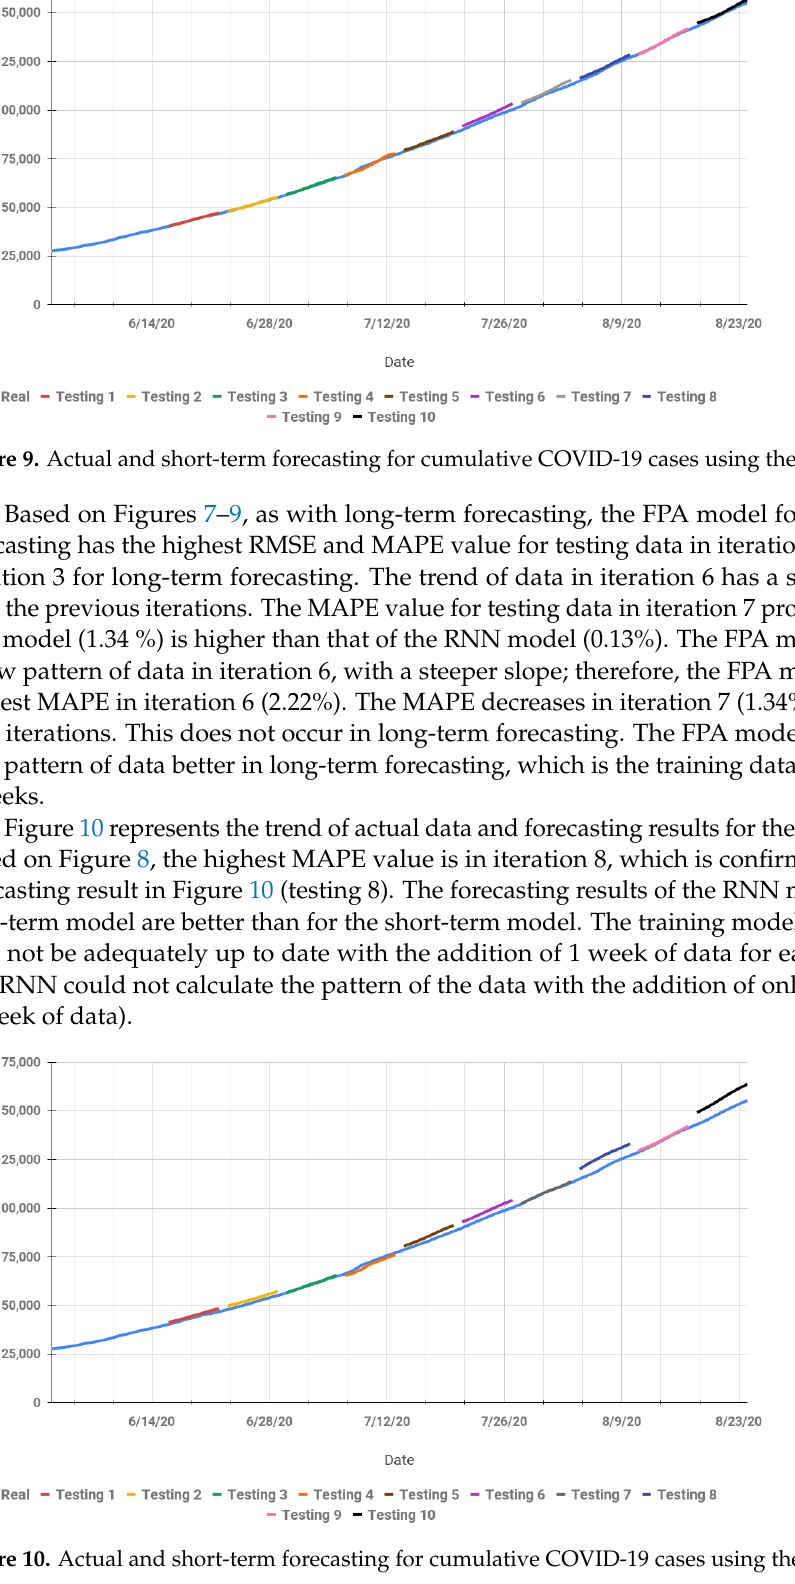
Figure 10. Actual and short-term forecasting for cumulative COVID-19 cases using the RNN model.